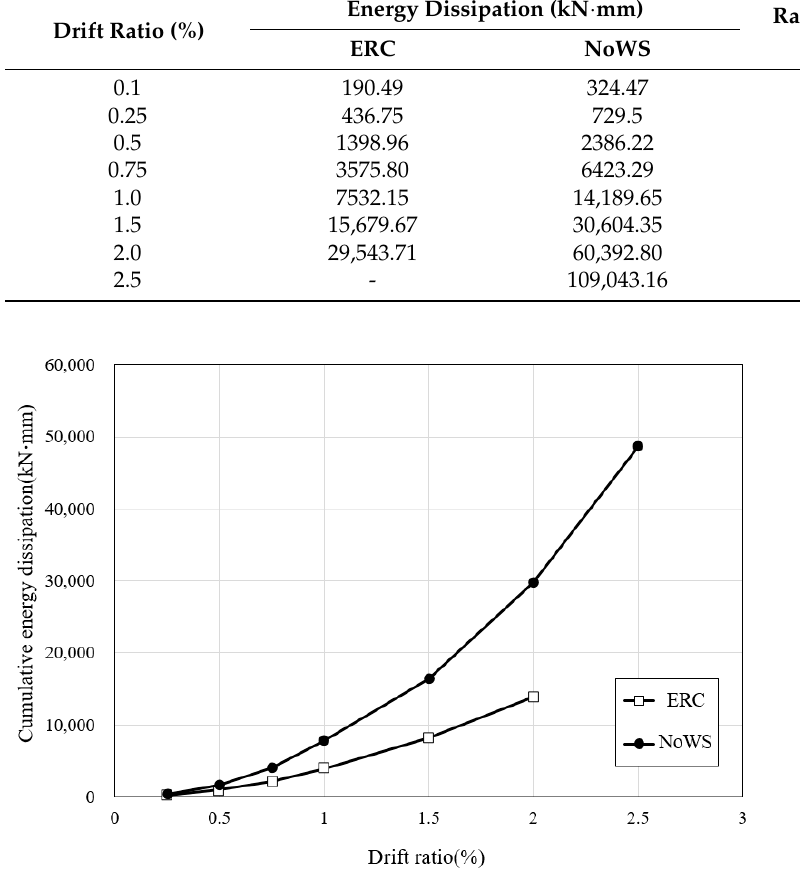
Figure 14. The difference between energy dissipation at the various drift ratios.